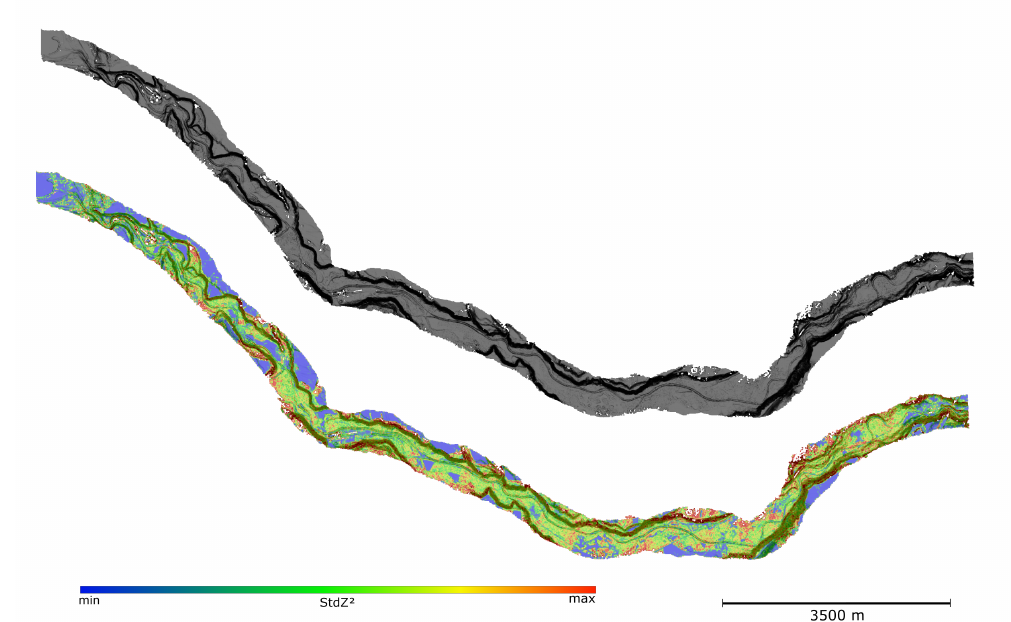
Figure 2. The whole flight strip shown as the processed DEM. Shown as shaded topography ( top ) and the variance of the estimated parameters ( bottom